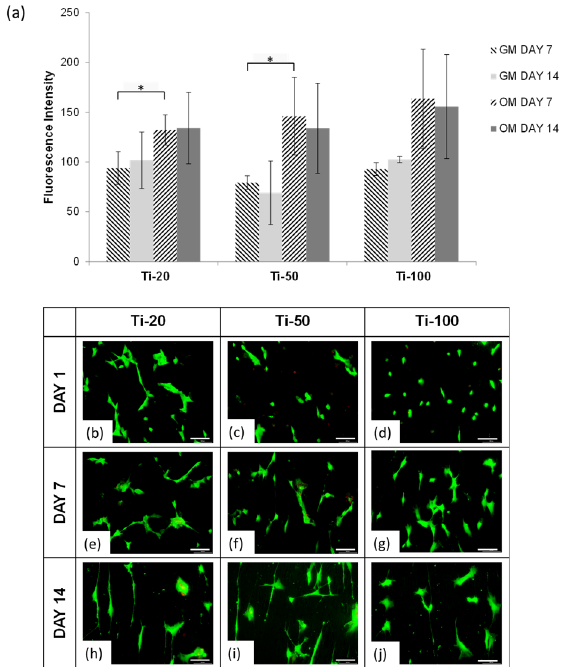
Figure 2. ( a ) AlamarBlue TM metabolic activity of human mesenchymal stem cells (hMSCs) cultured on anodised titanium samples with respective pore diameter at Day 7 and 14 in growth medium (GM) and osteogenic medium (OM). Values are mean ± S.D., n = 4, * p < 0.05; ( b – j ) LIVE / DEAD cell viability microscopy of human mesenchymal stem cells (hMSCs) cultured on anodised titanium samples with respective pore diameter at Day 1, 7 and 14 in growth medium. Live cells were stained green and dead cells were stained red. Scale bar = 100 µ